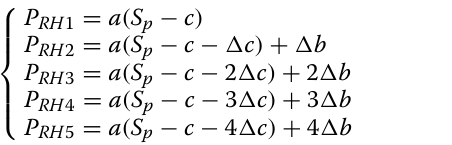
The five turning points